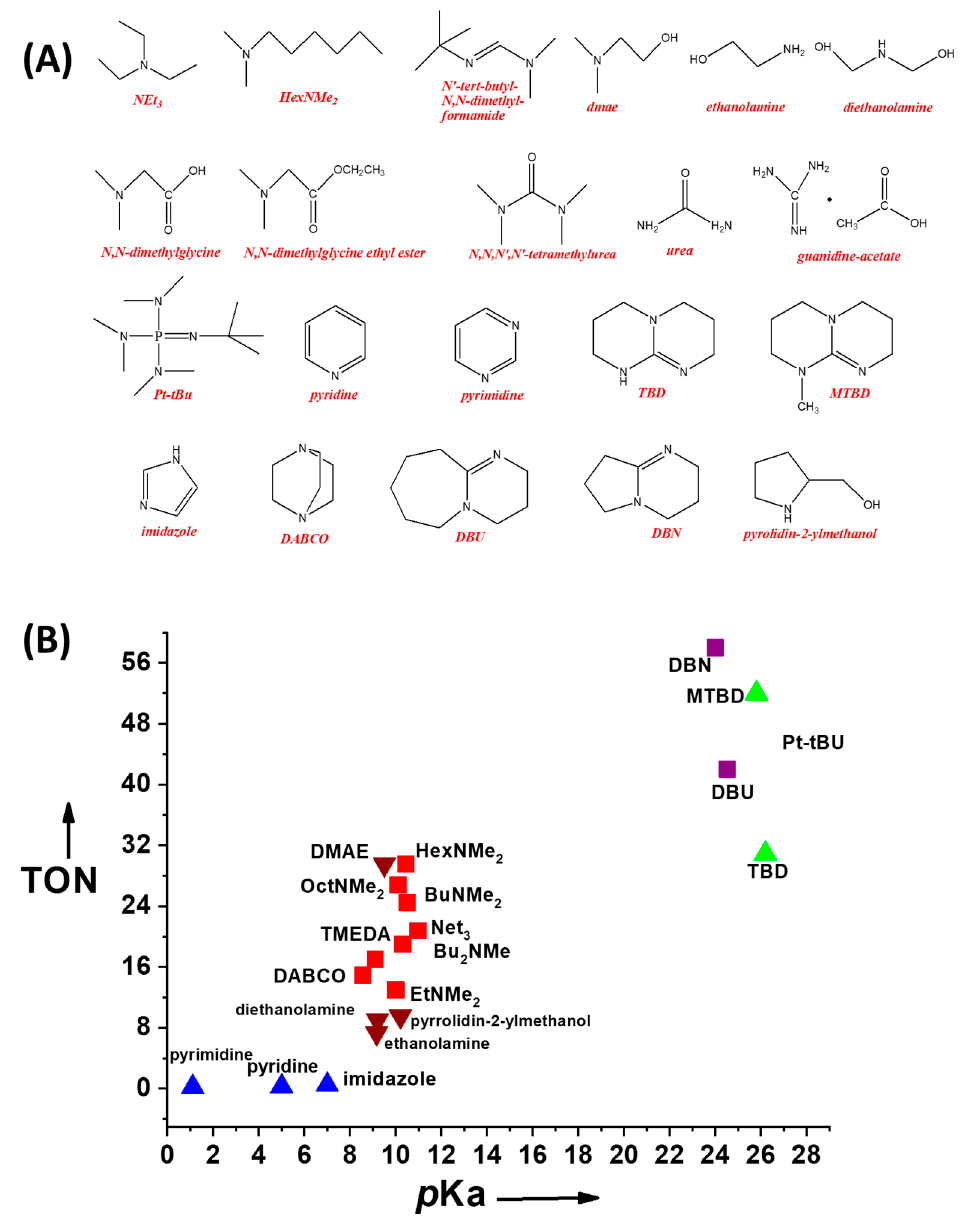
Figure 12. ( A ) Organic molecules used as a co-catalyst in the FA dehydrogenation reaction. ( B ) Correlation between the pKa of the co-catalysts with the Turnover Numbers (TONs) achieved. Figure adapted from Reference [61].